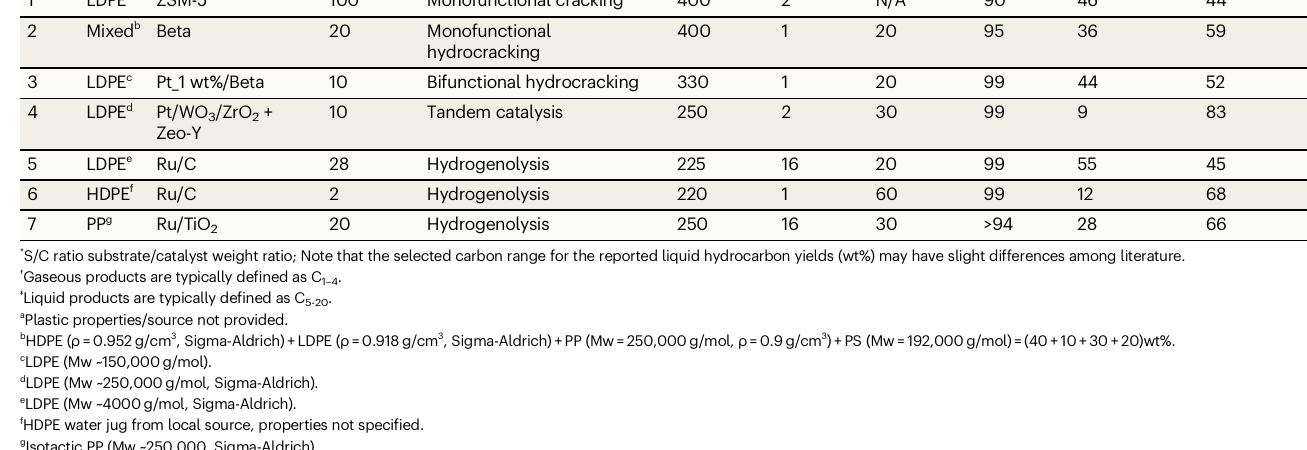
Table 1 | Plastic material depolymerizations via monofunctional-, bifunctional- hydrocracking, tandem catalysis, and hydro- genolysis pathways Entry